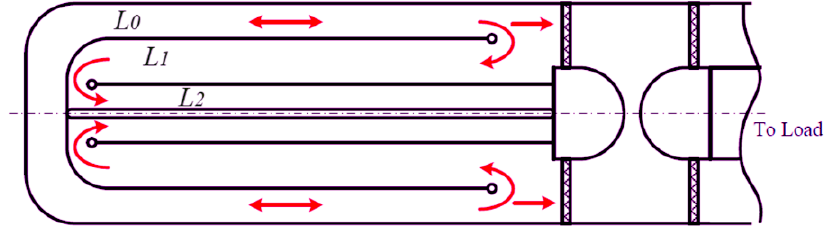
Figure 5. Simplified TWFL schematic.